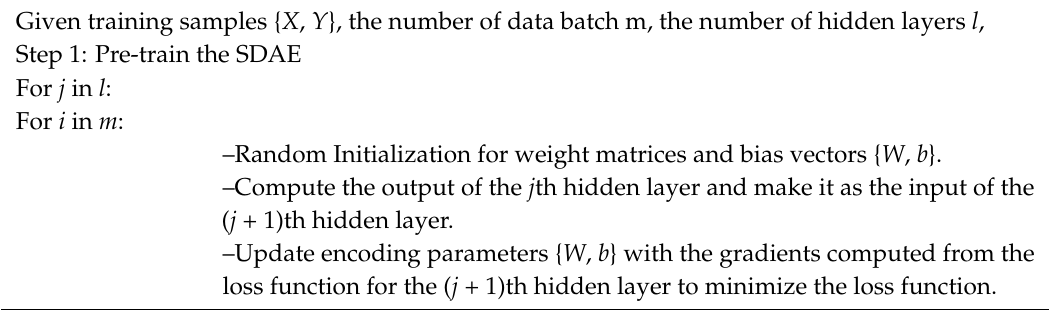
Algorithm 1. Training deep fault recognizer